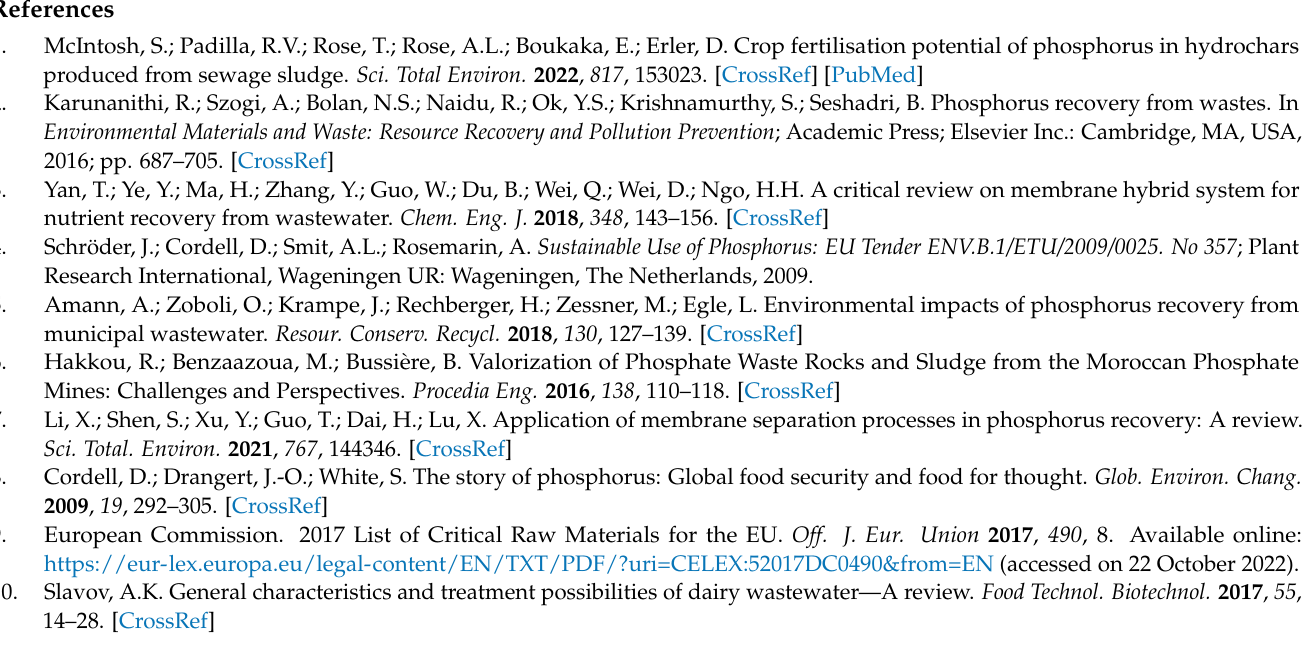
Figure S2b: Supernatant of the centrifugation process; Figure S3: The real picture of apparatus used for progressive freeze concentration; Figure S4: Flowcharts of the two stages of cheese whey valorisation using coupled technology of membrane system and freeze